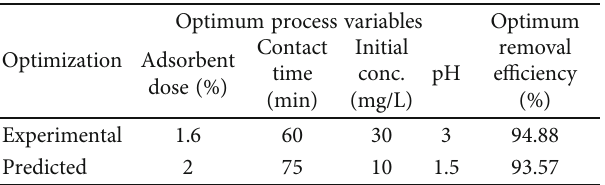
Table 10: Comparison of optimum process variables and removal e ffi ciency using experimental and software predictions.